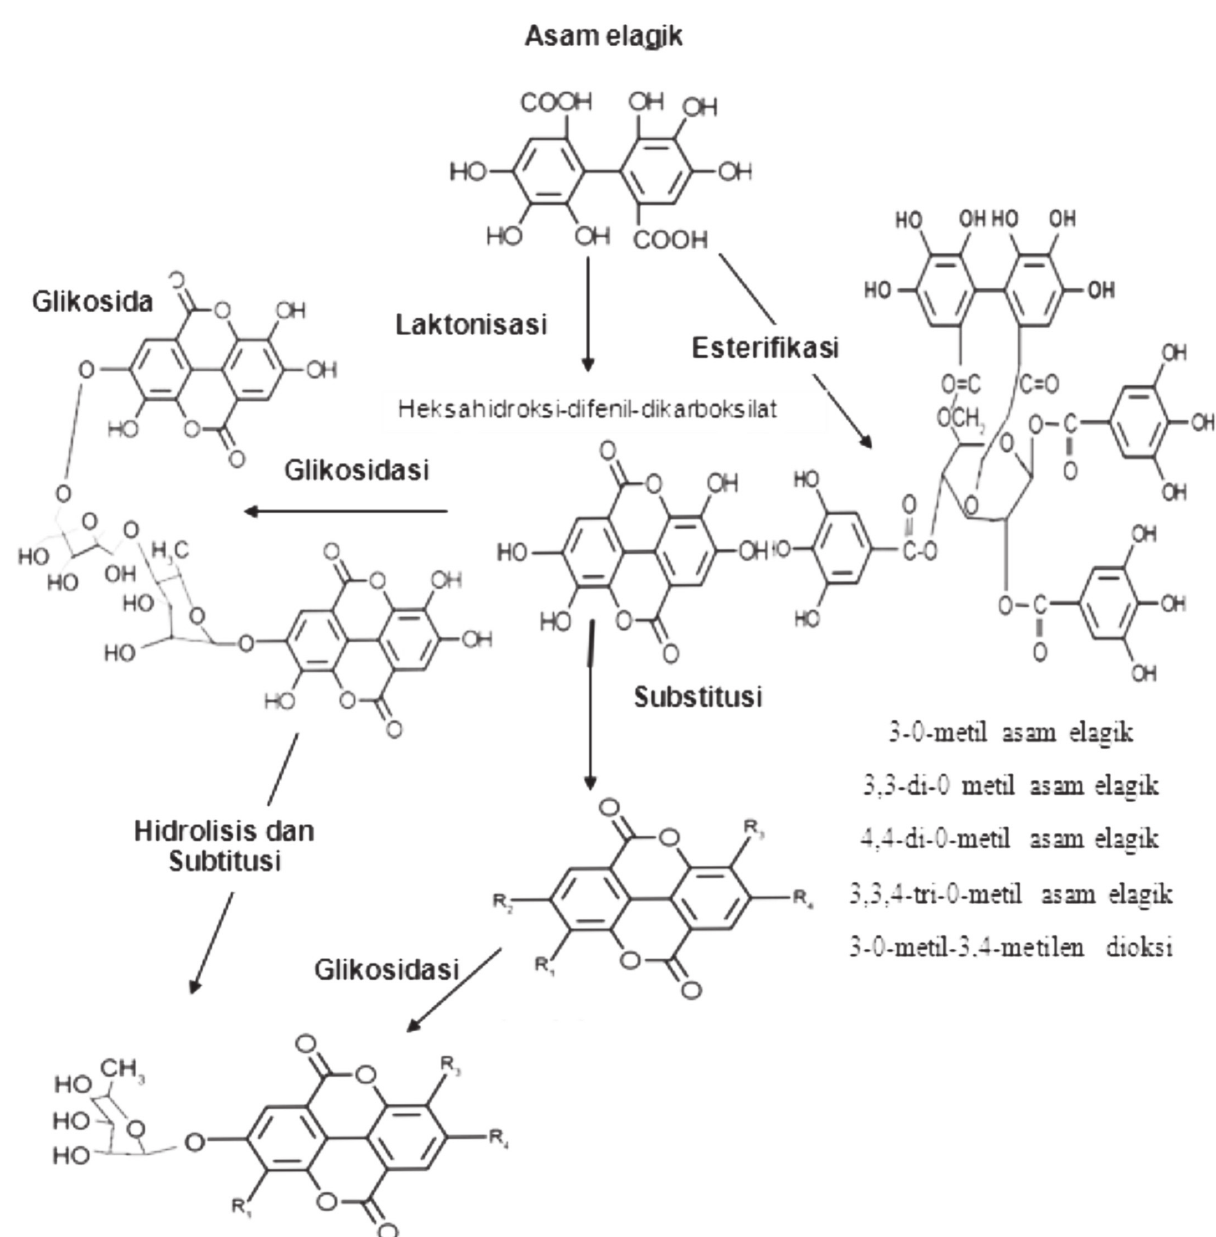
Figure 3. e Ellagic acid’s biosynthesis in pomegranate (Wang et al.,